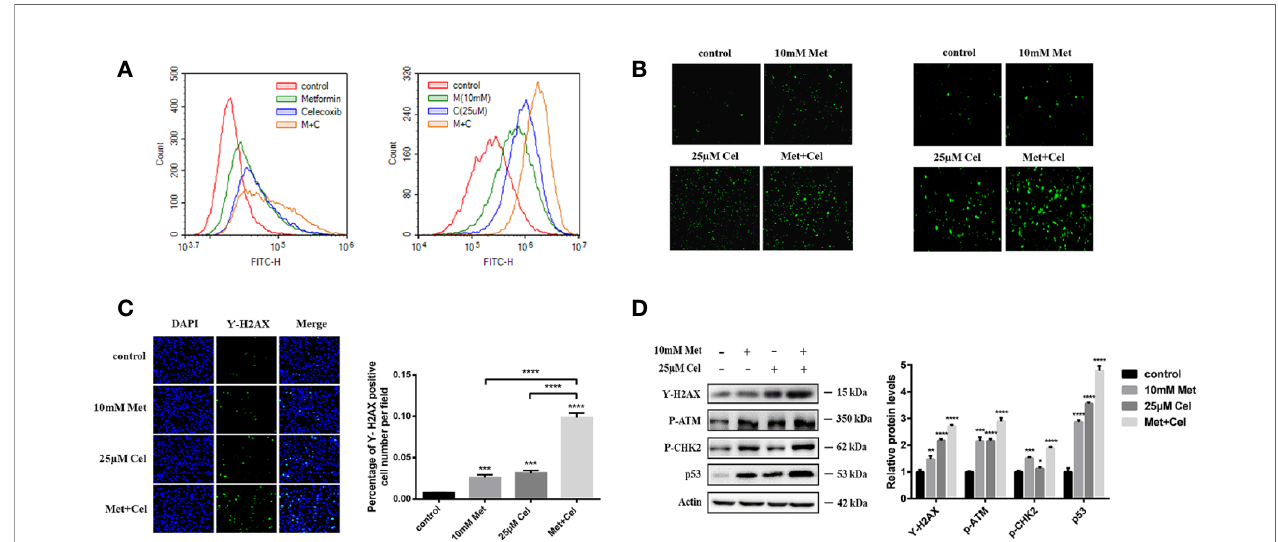
FIGURE 4 | Combined treatment with celecoxib and metformin increases reactive oxygen species and DNA damage in NSCLC cells. (A) Detection of ROS accumulation in A549 and H1299 cells by fl uorescent probe DCFH-DA. The change of fl uorescence intensity was observed by fl ow Cytometry. (B) Detection of ROS accumulation in A549 and H1299 cells by fl uorescent probe DCFH-DA. The change of fl uorescence intensity was observed by Fluorescence microscope. (C) Immuno fl uorescence staining of g -H2AX in A549 cells treated with 10 mM metformin and/or 25 m M celecoxib. (D) Effects of celecoxib and metformin on g -H2AX, p- ATM, p-CHK2, and p53 protein expression. A549 cells were treated with 10 mM metformin and/or 25 m M celecoxib for 48 h, and then harvested for WB analysis using indicated antibodies. The level of actin served as the loading control. Band intensities were calculated using software Image J. Relative intensities are also shown. Data represent mean values of triplicate samples. Data are represented as mean ± SD. * p < 0.05, ** p < 0.01, *** p < 0.001, **** p <